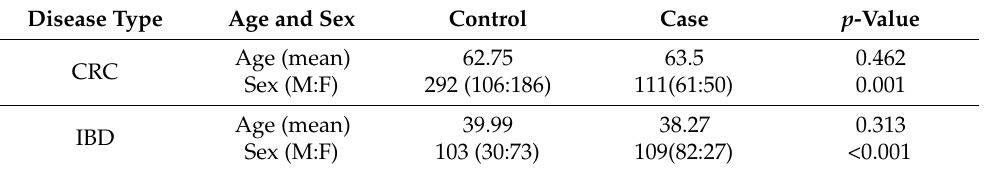
Table 1. Clinical characteristics of each disease